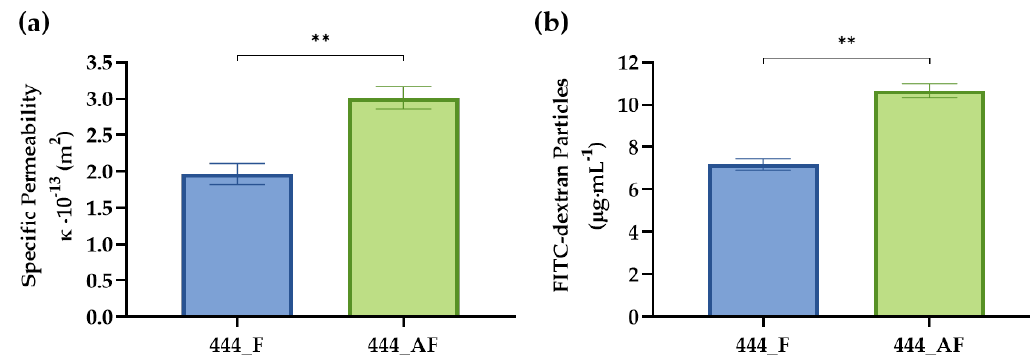
Figure 4. ( a ) Measured specific permeability values and ( b ) diffusion of FITC-dextran 70 kDa particles from the scaffolds to the growth medium over 24 h for 444 networks impregnated with fibrin (444_F) and albumin-rich fibrin (444_AF) hydrogels. Bars represent the mean ± standard error for each tested group ( n = 5 samples from each group). Statistical analysis was conducted by unpaired t test, ** p < 0.01.